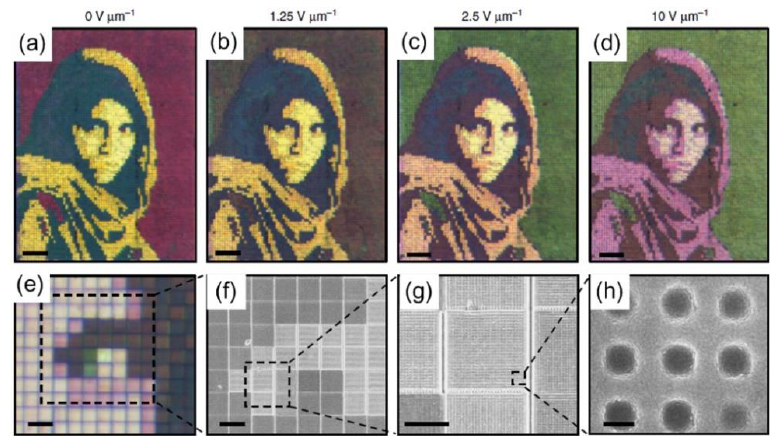
Figure 13. Dynamic color tuning using LCs. ( a – d ) Microscope images of captured portrait at varying applied voltages. ( e ) Magnified image at 10 Vμm −1 showing more details. ( f – h ) SEM images of fabricated structural pixels. Scale bars, ( e ) 20 μm, ( f ) 10 μm, ( g ) 5 μm, ( h ) 150 nm. Reproduced with permission from [119]. Copyright Macmillan Publishers Limited, 2015.